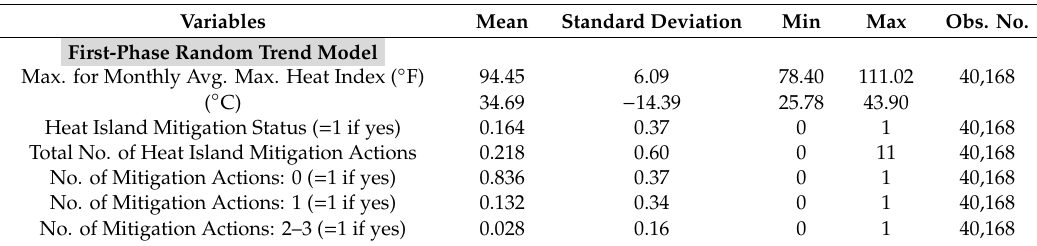
Table 5. Summary